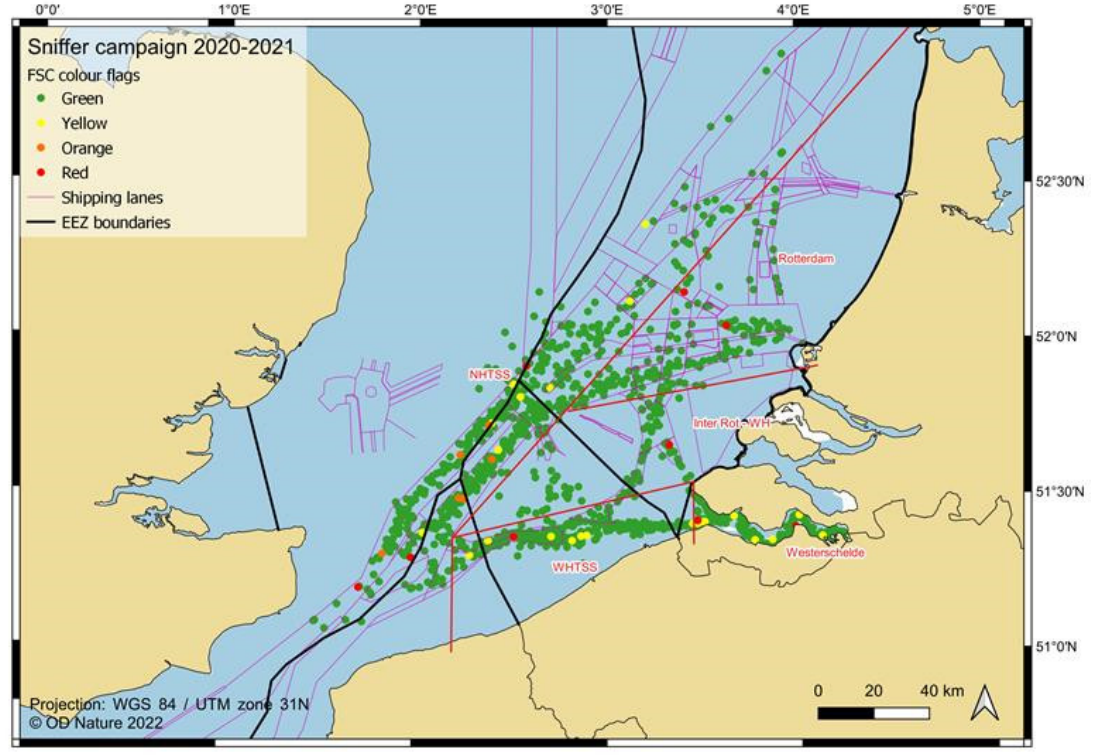
Figure 8. Spatial distribution of FSC measurements based on the color flags in the period from 2020–2021, with the location of the different zones: North–Hinder Traffic Separation Scheme (NHTSS), West–Hinder Traffic Separation Scheme (WHTSS), Westerschelde, Rotterdam and the area between WHTSS and Rotterdam Inter WH-Rot).